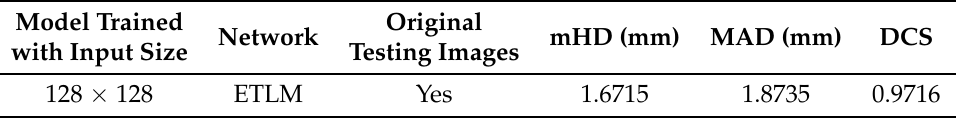
Table 9. Level three: measurement evaluation based on testing